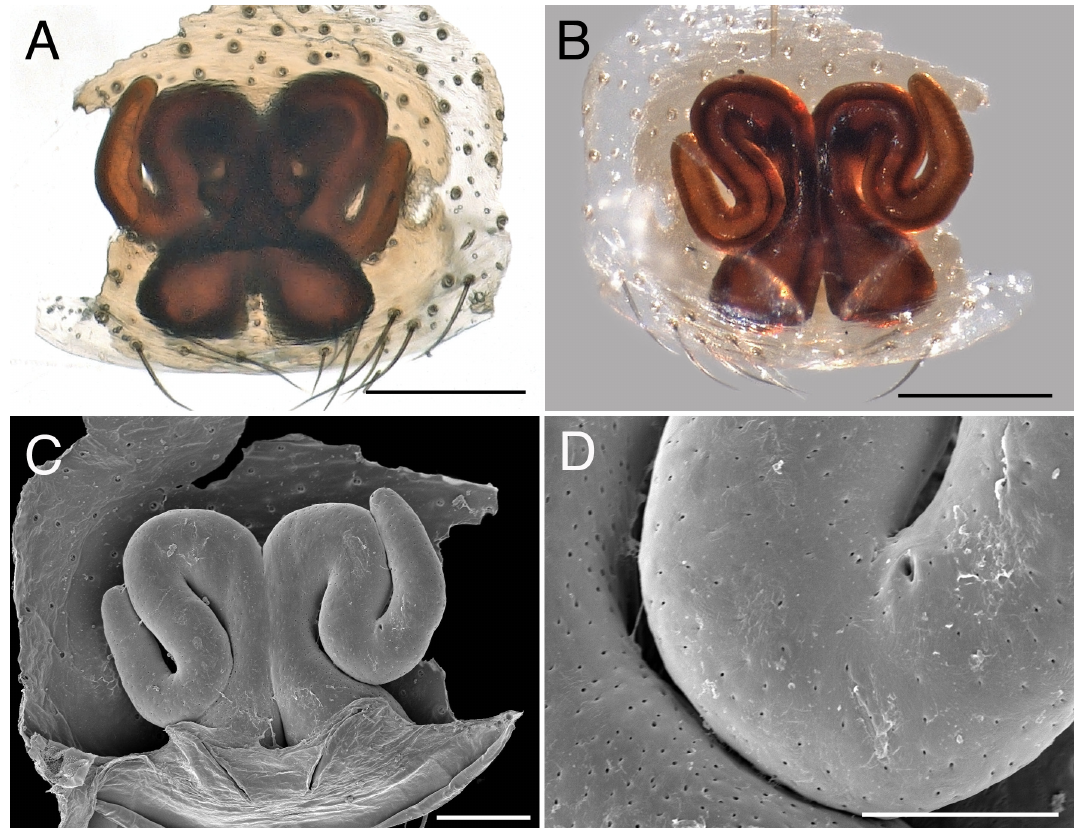
Fig. 5. Ballomma erasmus gen. et sp. nov. Paratype, ♀. A . epigyne, cleared, ventral view. B .